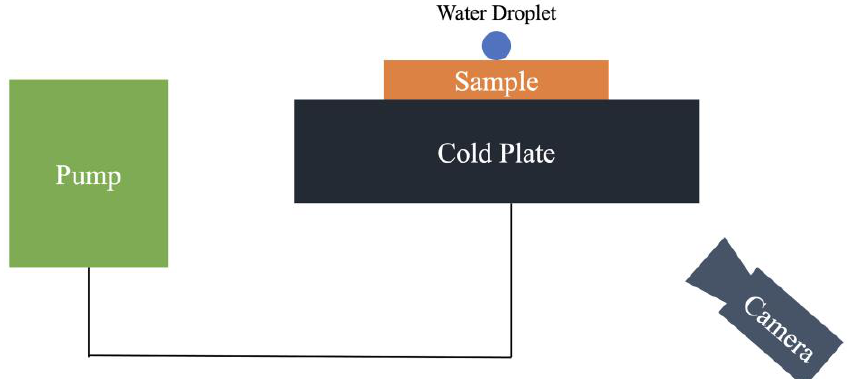
Figure 1. Schematic Diagram of the Experimental Setup.